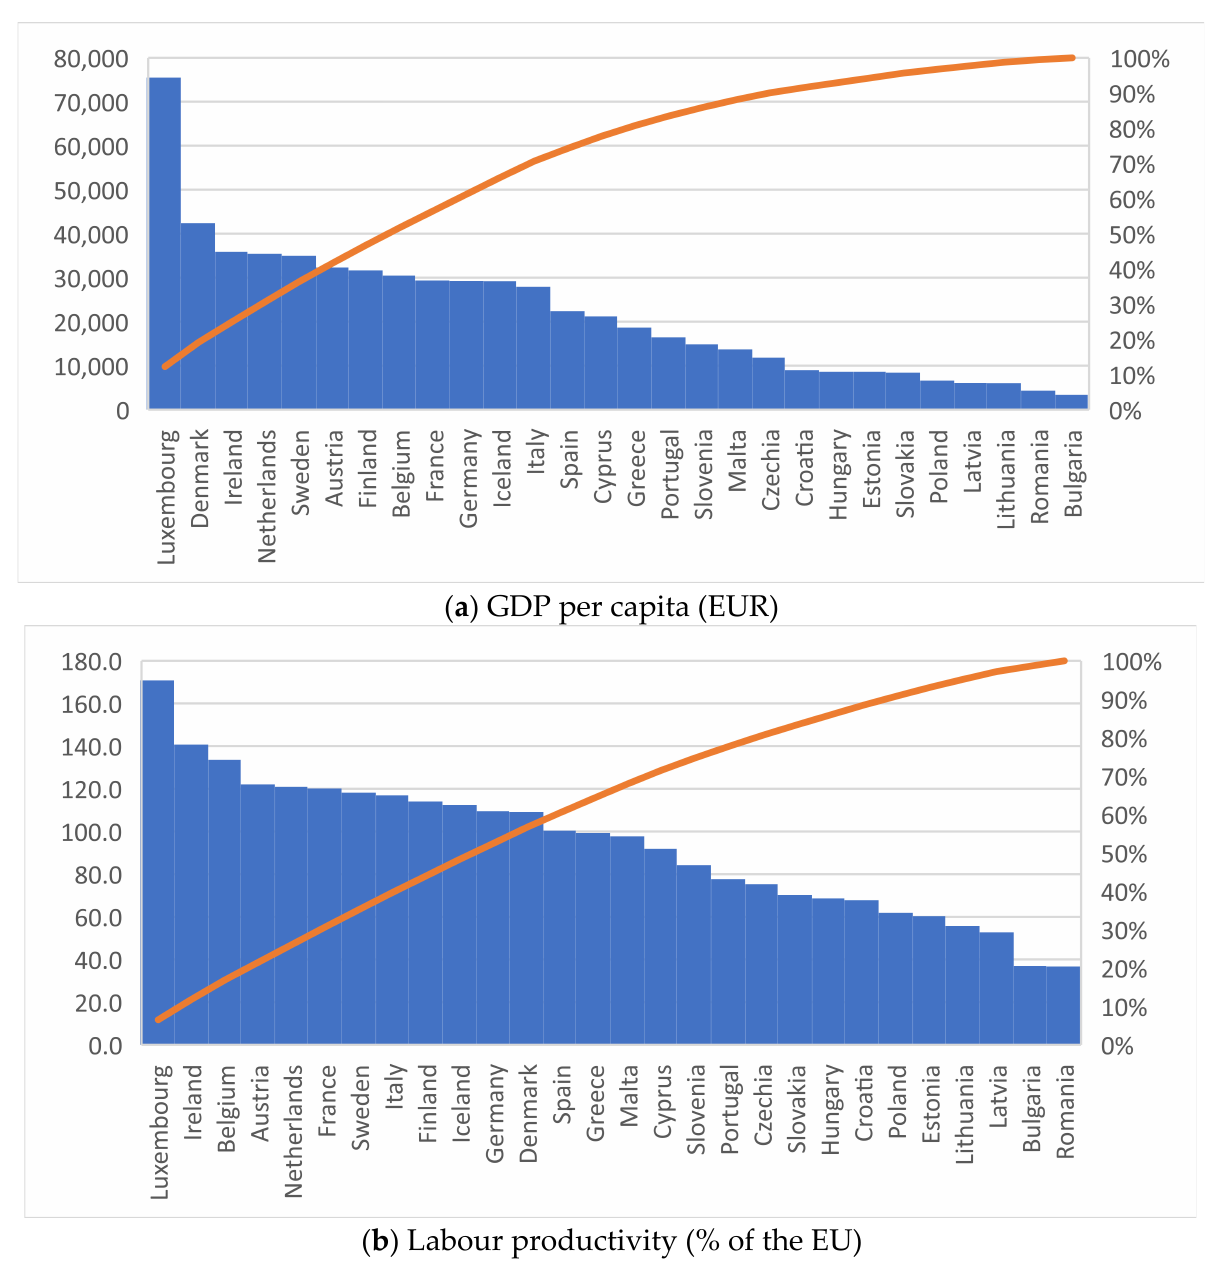
Figure 1. The real GDP per capita and labour productivity in the EU (source: Eurostat). According to the Eurostat database [32], there is a lack of homogeneity among the EU countries regarding digitalisation. As Figure 2a shows, Romania leads, recording the highest digital intensity, but, paradoxically, it records the lowest labour productivity, meaning that the digital technologies are concentrated, at large, in urban-located companies, whereas other, smaller companies lack such investments. Croatia has the highest percentage of enterprises linked with customers and suppliers. Austria is most advanced in using marketing-related software, and Portugal and Romania are most oriented towards the sustainable use of digital equipment. Nevertheless, concerning digital skills (Figure 3a), Romania lags, with Iceland recording the best skills, while in Estonia, individuals have carried out the most internet-related activities (Figure